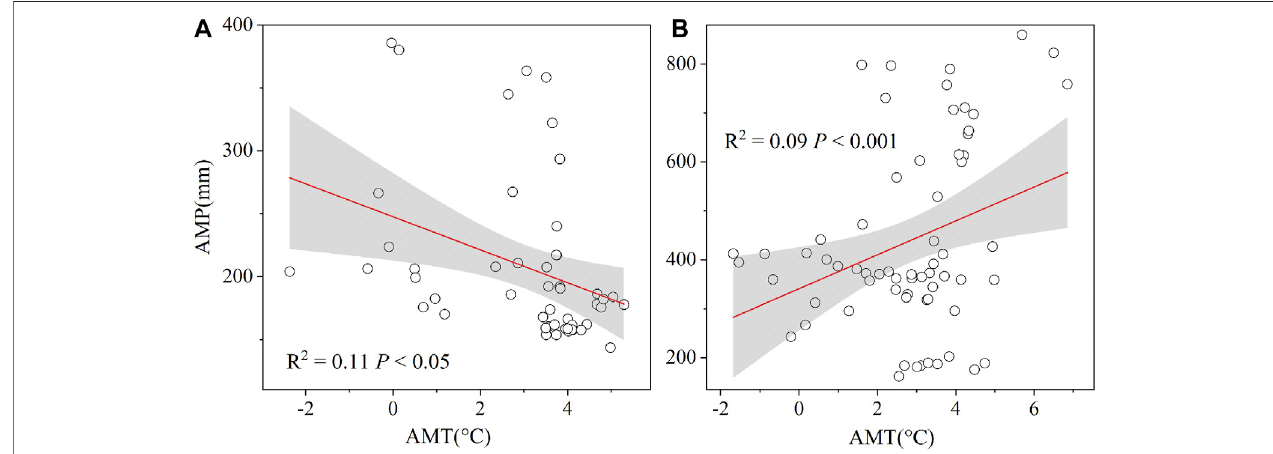
FIGURE 6 | Relationship between the annual mean temperature (AMT) and annual mean precipitation (AMP) in low (A) and (B) high patterns, respectively.